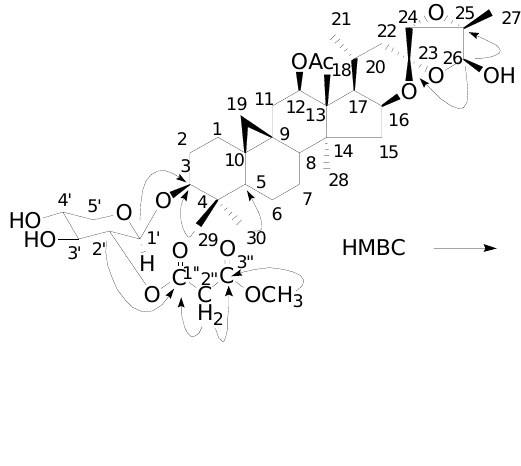
Figure 3. The key HMBC correlations of 2